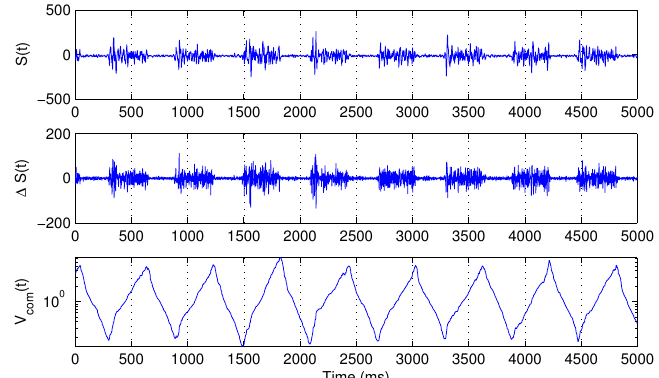
Figure 1. Several bursts of the surface electromyography (sEMG) signal S ( t ) ( top ), its backward difference ∆ S ( t ) ( middle ) and the corresponding V Equation (3) ( bottom